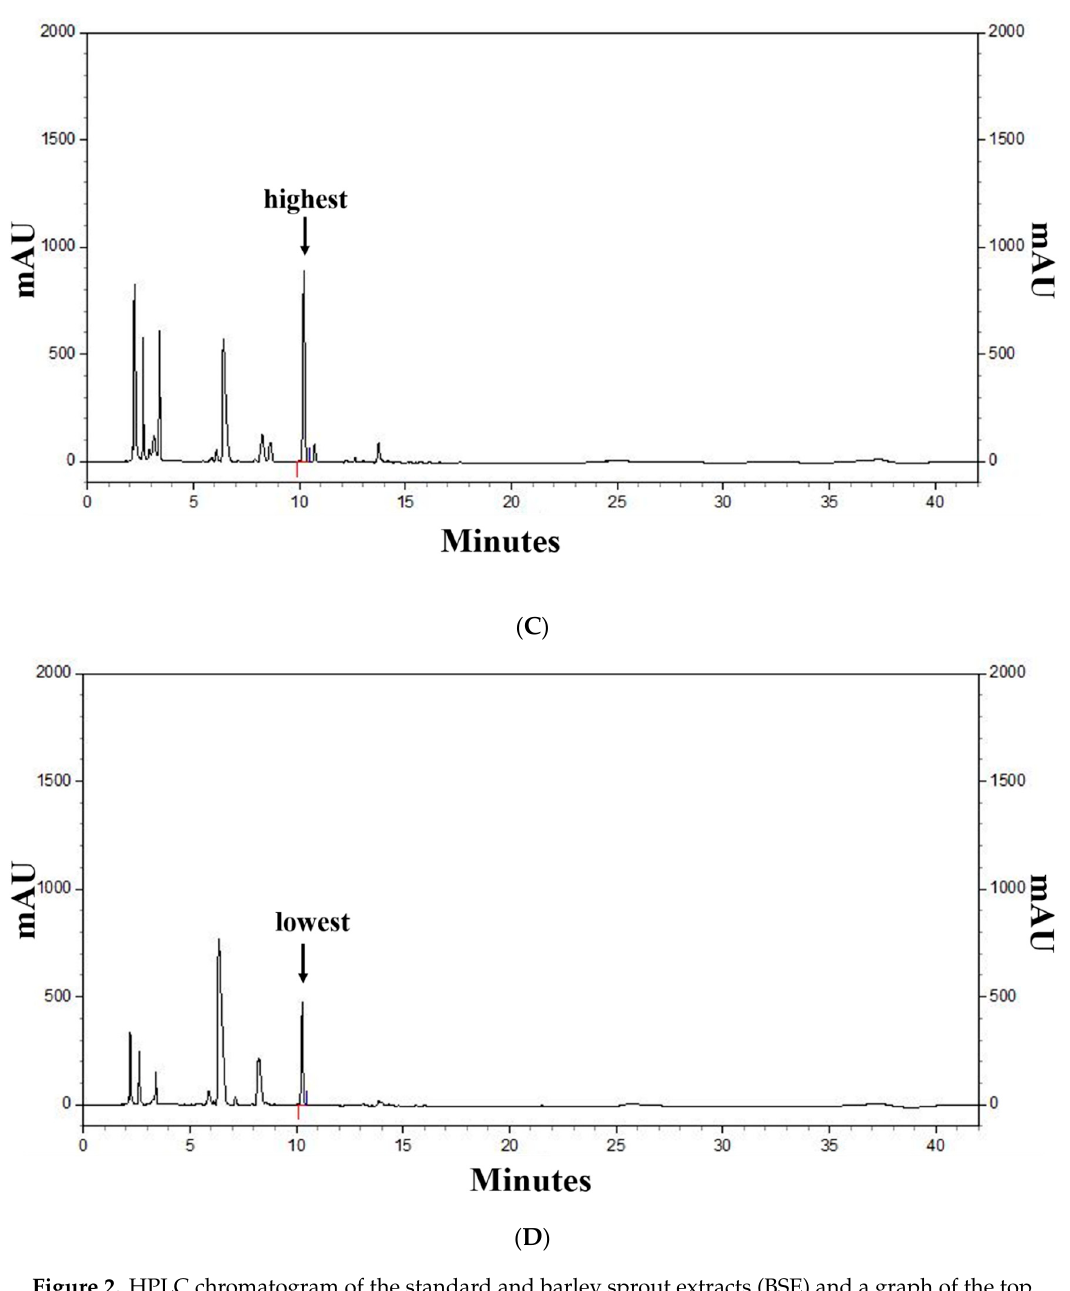
Figure 2. HPLC chromatogram of the standard and barley sprout extracts (BSE) and a graph of the top and bottom five BS samples for saponarin content. HPLC chromatogram standard ( A ) and standard quantitative curve ( B ), and HPLC chromatogram of the BS samples with the highest ( C ) and the lowest saponarin contents ( D ). Saponarin appeared with retention times of approximately 10.3 min at 254 nm.